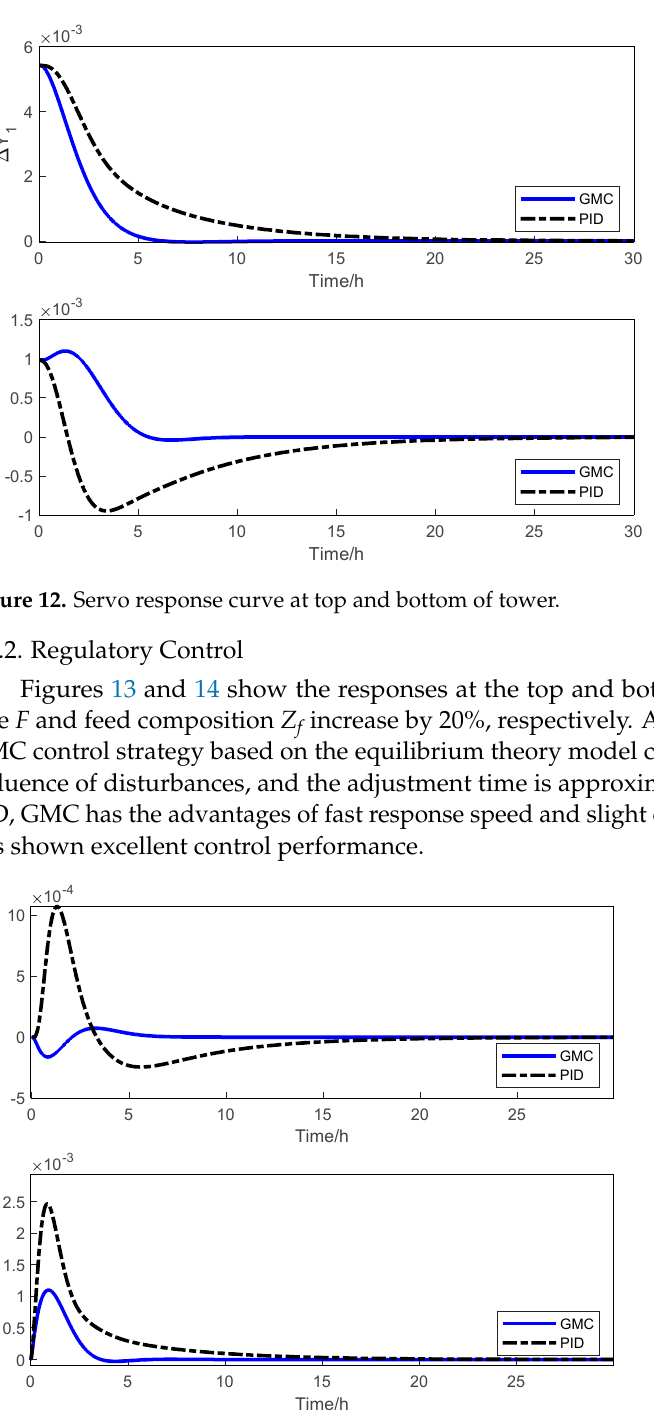
Figure 14. Response curve of controlled variable when the feed composition Z f +20% in Case 1. Table 4. Error index of GMC in Case 1. Servo Control